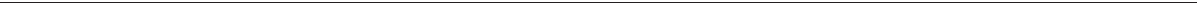
Fig. 2 Systemic activation of human immune responses in high-dose IL-2 human immune system mice. 10 − 14-week-old human immune system (HIS) mice treated with PBS, low-dose IL-2 (LDIL2) or high-dose IL-2 (HDIL2) were killed at day 6 post injection. Sera were collected at day 6 post injection. a Absolute cell numbers ± SEM for human CD45 + and CD3 + cells in spleen of HIS mice treated with PBS, LDIL2 or HDIL2. The data are pooled from four independent experiments. b − d Percentages ± SEM of indicated human immune subsets b , transcriptional factor expression within T cell subsets c , and cytokine producing T cells d from spleens of HIS mice treated with PBS, LDIL2, or HDIL2. The data are pooled from two independent experiments, analyzed by 1-way ANOVA test with a Tukey test. e Serum cytokine levels were analyzed from non-treated HIS mice and HIS mice treated with PBS, LDIL2, or HDIL2. The data are pooled from four independent experiments, and analyzed by 1-way ANOVA test with a Tukey test. * P < 0.05, ** P < 0.01, *** P < 0.001, **** P < 0.0001